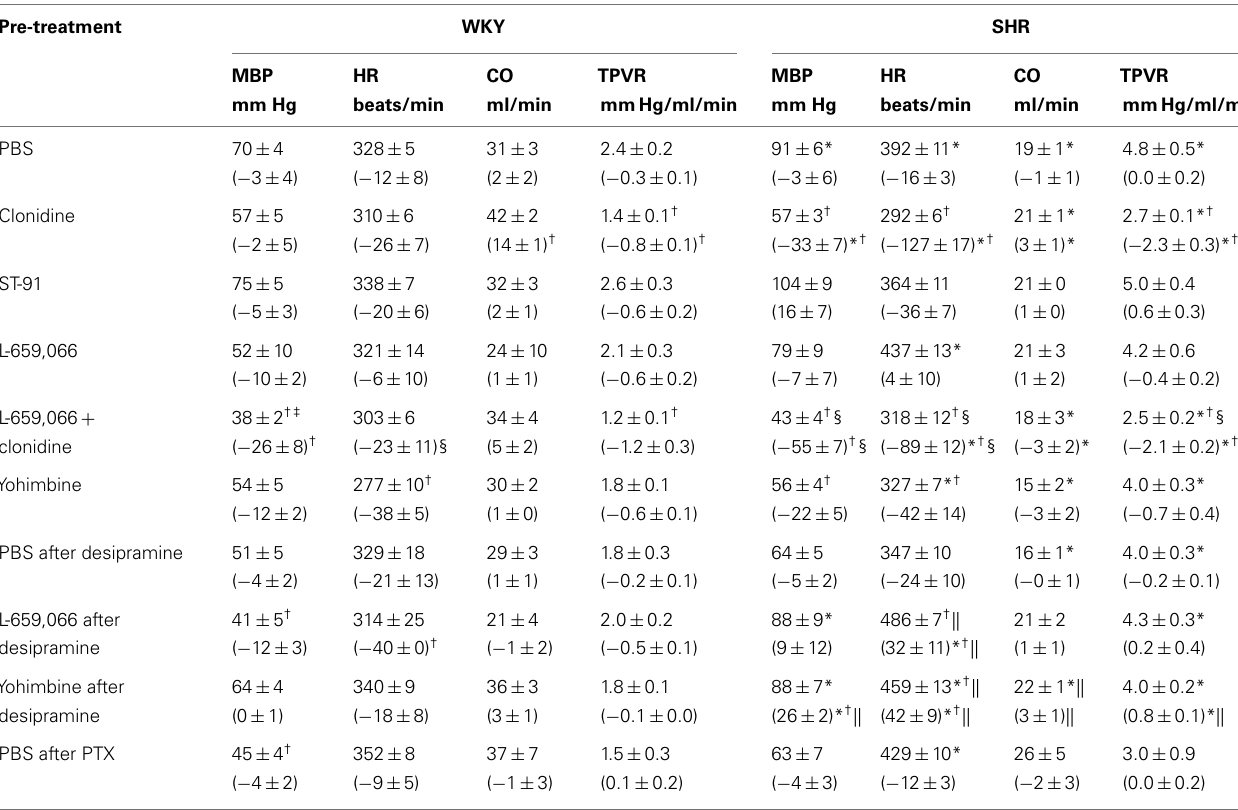
Table 2 | Cardiovascular baselines prior to phenylephrine and, in parenthesis, the response to pre-treatment during the acute experiment.